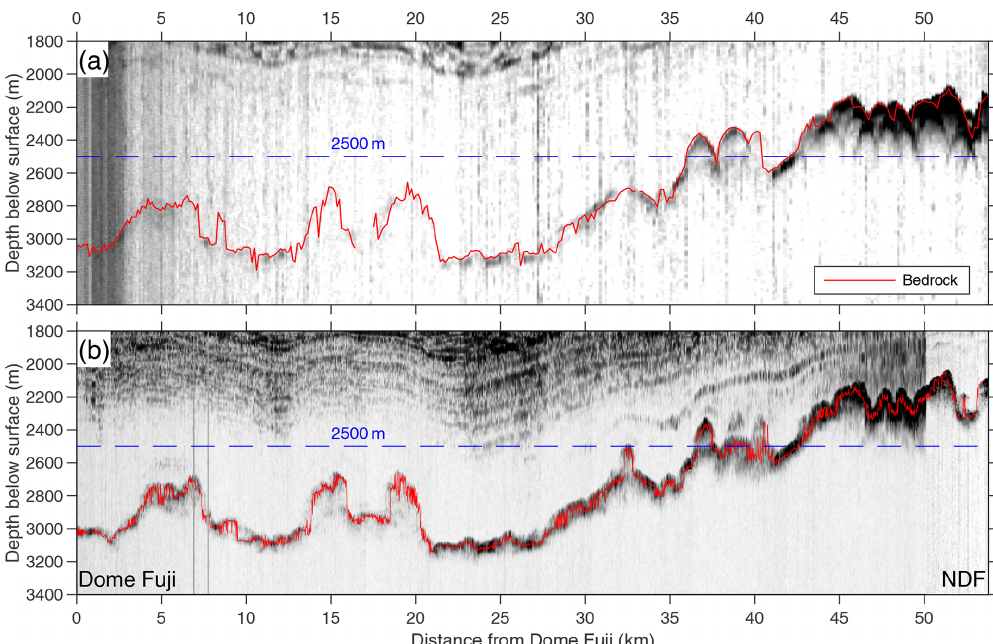
Figure 2. Radargrams between Dome Fuji and NDF acquired by the radar systems used in (a) JARE54 (2012/13) with 3-element Yagi antenna and (b) JARE59 (2017/18) with 11-element Yagi antenna. The lines indicate bedrock topography traced from the radar data. Note that radargrams shown in (b) were generated by data acquired on 17 and 21 December 2017. The colour range in radargrams (a) and (b) is 1.25–1.80 and − 110–0dBm, respectively.